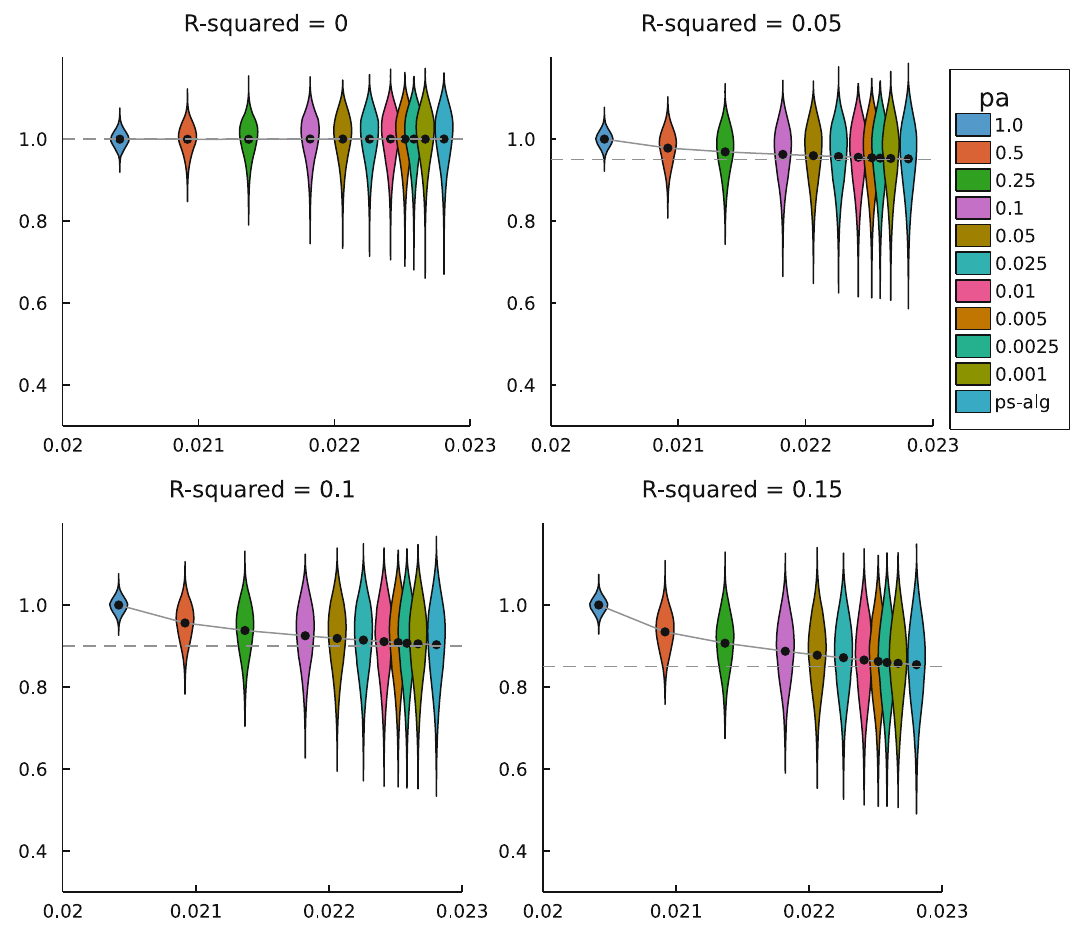
Figure 2: Distribution of MSE ( y - axis ) against assignment correlation ( x - axis ) for di ff erent designs, normal covariates. Note: The plots are violin plots indicating the distribution of the MSE for di ff erent designs. The dashed line shows the expected MSE if covariates are perfectly balanced ( R 1 − 2 ) . The black dots indicate the mean of the distribution of MSE for each design, connected with a gray